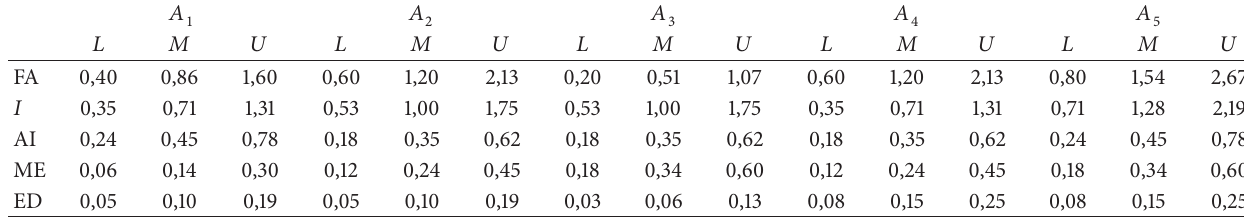
Table 16: The weighted normalized decision matrix.